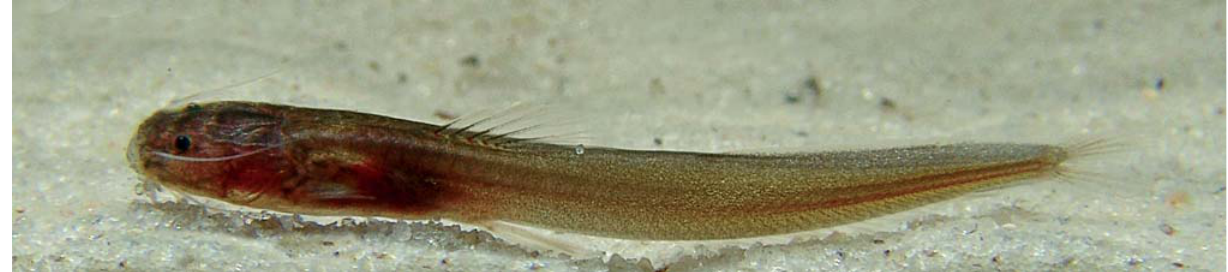
Fig. 2. Gladioglanis anacanthus , holotype, INPA 28446, 26.3 mm SL, live specimen. Photograph by L. M. de